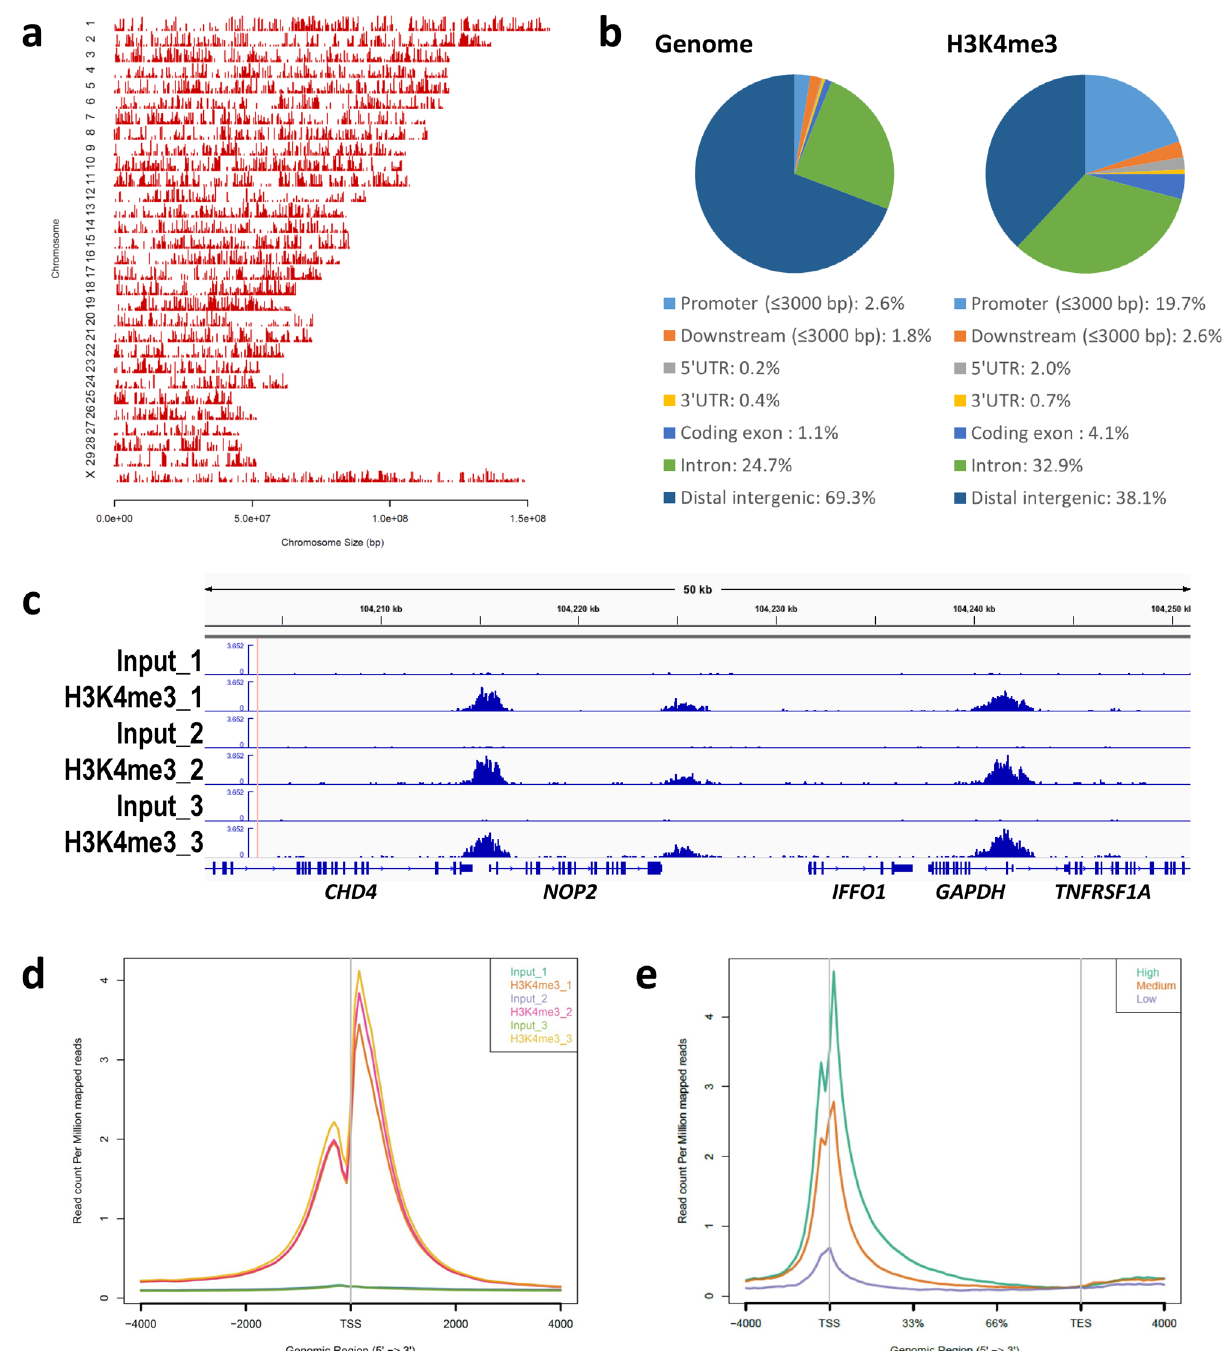
Figure 1. Overview of H3K4me3 ChIP-seq results in bovine blastocysts. ( a , b ) Distribution of H3K4me3 peaks in each chromosome ( a ) and in corresponding genic and intergenic regions ( b ). These figures were generated by the CEAS 35 tool using the H3K4me3_1 (Blastocyst_1) sample. ( c ) Snapshot of the H3K4me3 landscape in a 50-kb region (chromosome 5) that encompasses the GAPDH TSS. The ChIP peaks in the triplicates were visualized using the Integrative Genomics Viewer 36 . ( d ) Average profile plot of the H3K4me3 signal around the genome-wide TSSs. The signals from the triplicates are shown. ( e ) Average profile plot around gene bodies categorized by gene groups with different expression levels based on GSE52415 37 . The H3K4me3_1 sample was used to generate the figure. The average profile plots were generated by ngs.plot 21